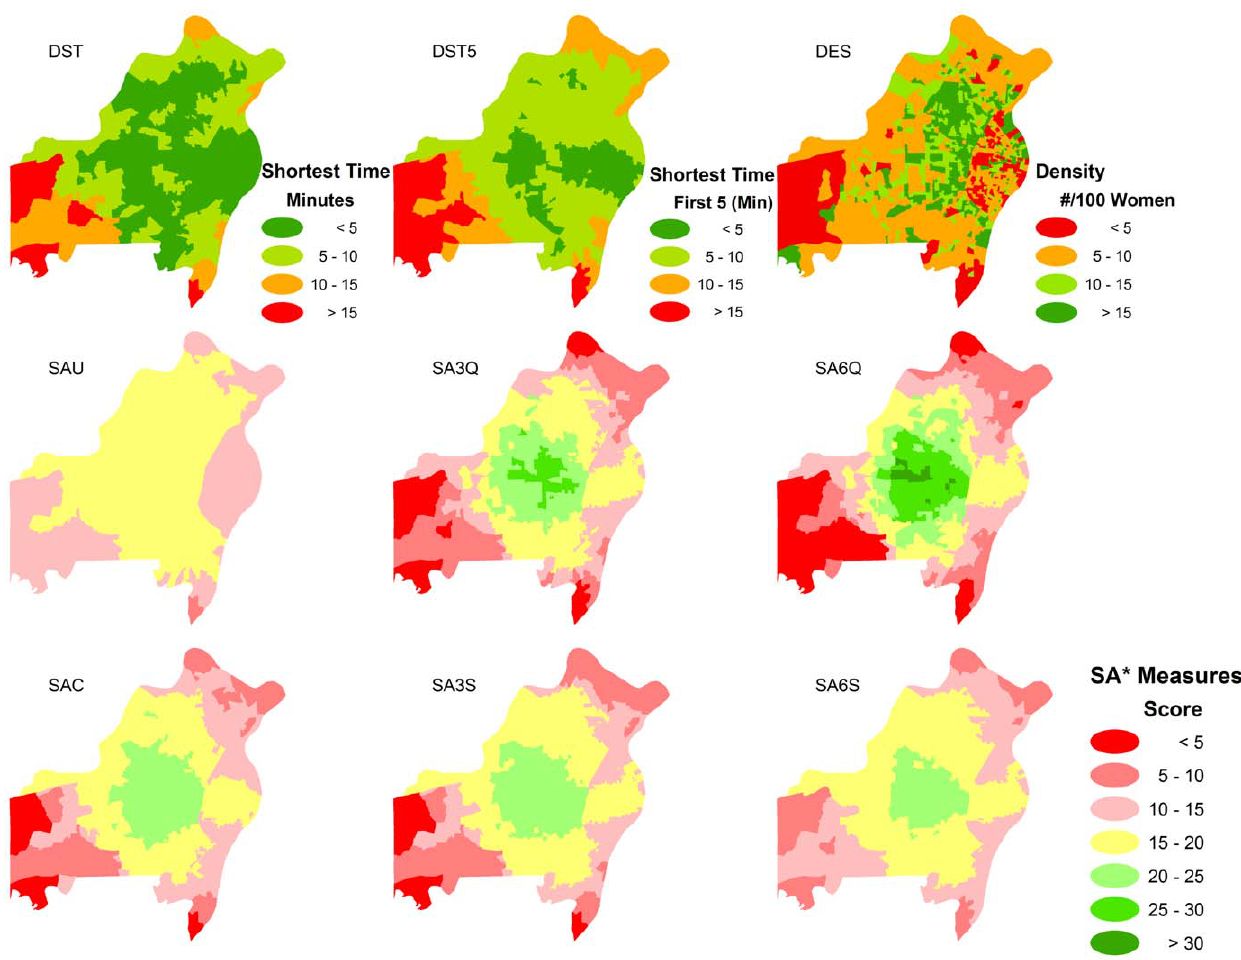
Figure 1. Distribution of nine GIS-based measures in access to mammography in St. Louis.